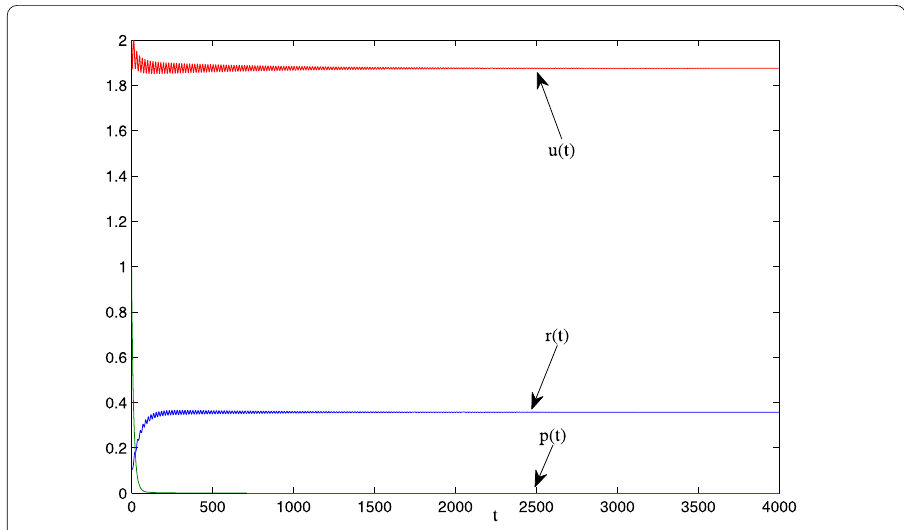
Figure 2 The asymptotical stability with delay τ = 13.5. The parameters of system (5) are c 1 = 0.8, c 2 = 0.1, c 3 = 0.9, c 4 = 0.6, s 1 = 0.6, s 2 = 0.1, b = 0.3, d 1 = 0.9, d 2 = 0.1, d 3 = 0.1, and α = 0.98; the initial values are r ( t ) = 0.1, p ( t ) = 1, u ( t ) = 2 ( t ∈ [– τ ,0]). The Hopf bifurcation critical value τ a ≈ 13.5888. It depicts the